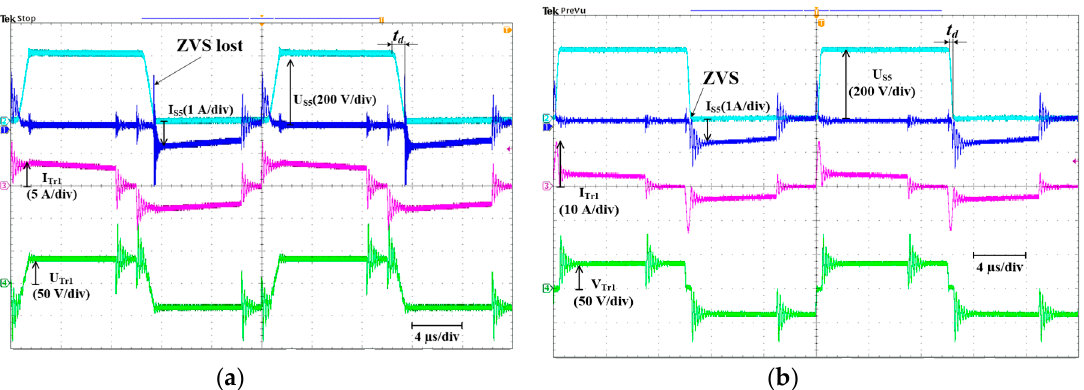
Figure 10. Theoretical and experimental operating boundaries.